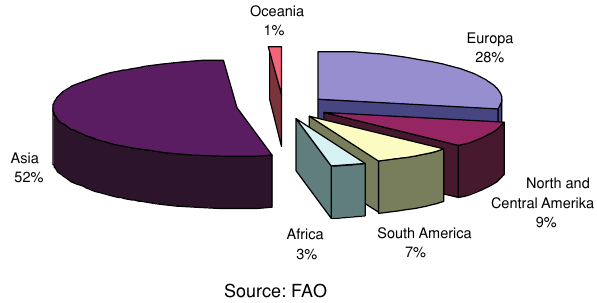
Figure 1: Distribution of apple production of the world (2005)